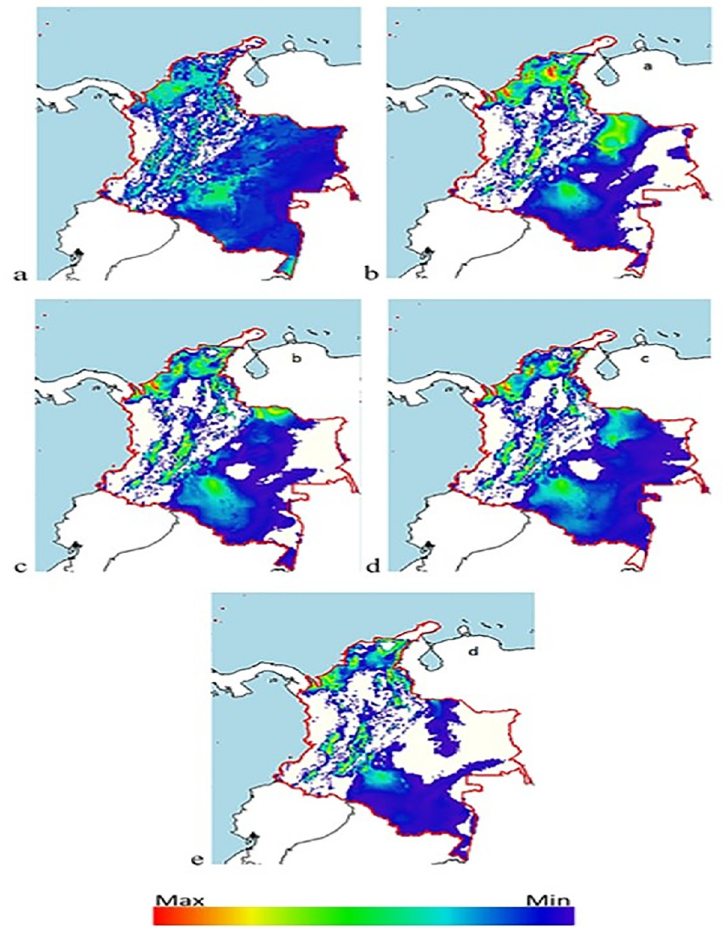
Fig 10. Distribution of Diatraea spp. in Colombia under different climate change (BCC-CSM1-1) and carbon concentration projections over 50 years. a) current condition, b) rcp26, c) rcp45, d) rcp60, e) rcp85. Color indicates maximum or minimum presence in a likely niche and under favorable